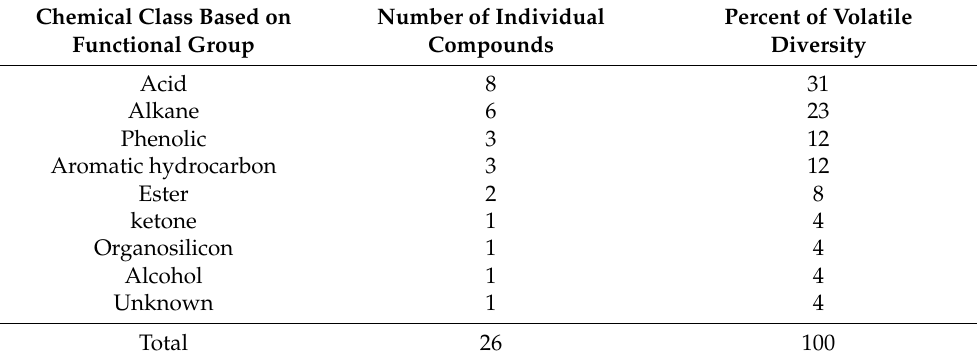
Table 3. The different classes of chemical compounds were found across the 36 experimental ciders, each represented by the number of individual compounds and percentage of volatile diversity. Chemical Class Based on Functional